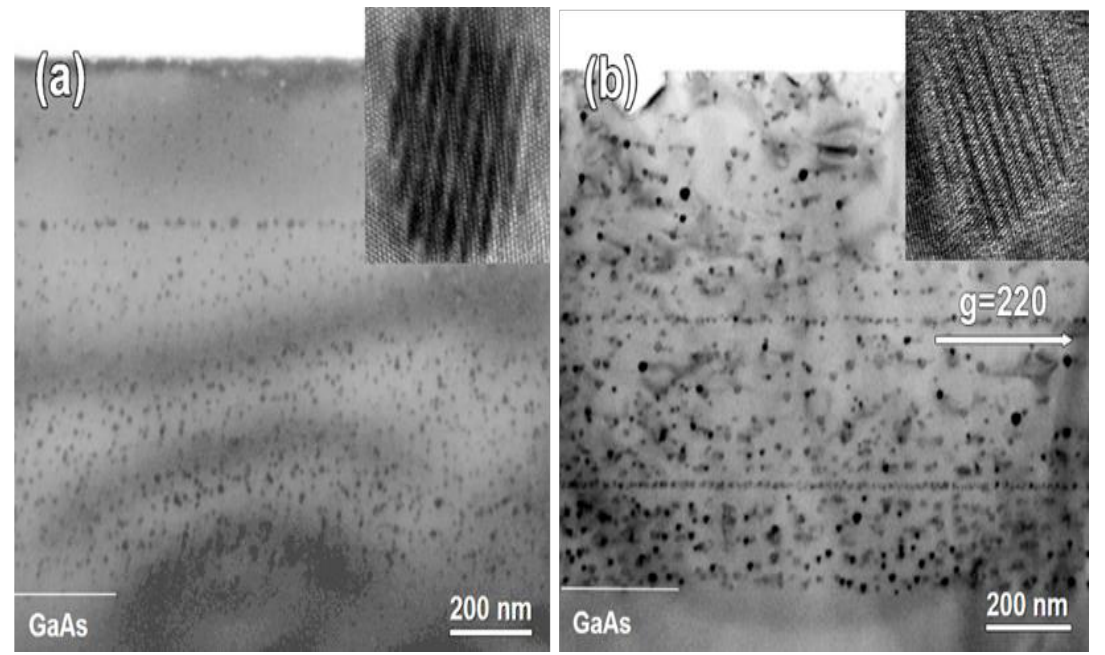
Figure 2. Bright-field cross-sectional TEM micrographs of the samples annealed at 600 °C: ( a ) LT-GaAs ([110] zone axes); ( b ) LT-GaAs 0.97 Sb 0.03 (two-beam conditions, g = 220). The insets are high-resolution images of individual nanoinclusions.